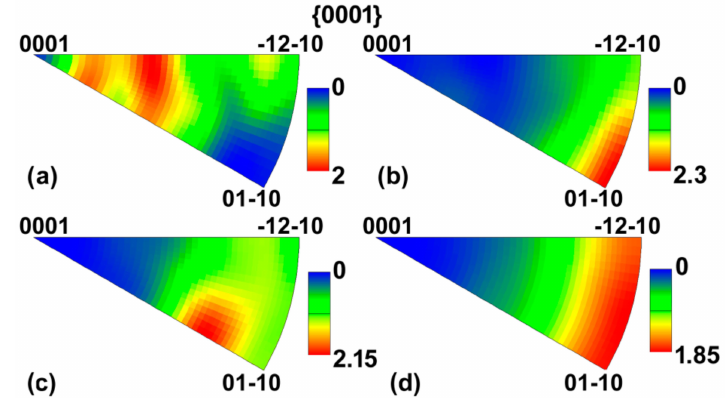
Figure 6. Inverse pole figures for samples: RS-ST ( a ); RS + 400 RPM FSP ( b ); RS + 800 RPM FSP ( c ); RS + 1200 RPM FSP ( d